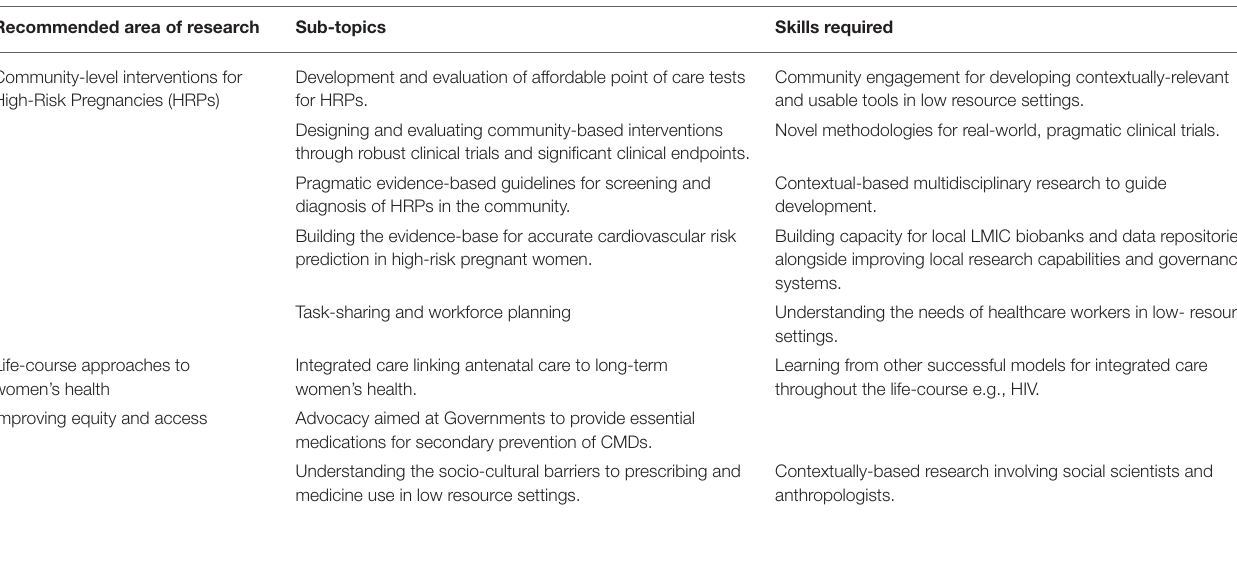
TABLE 1 | Summary of research